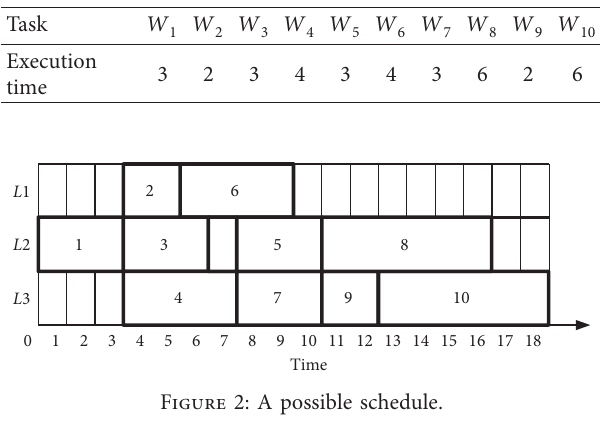
Table 1: Execution times of the tasks.